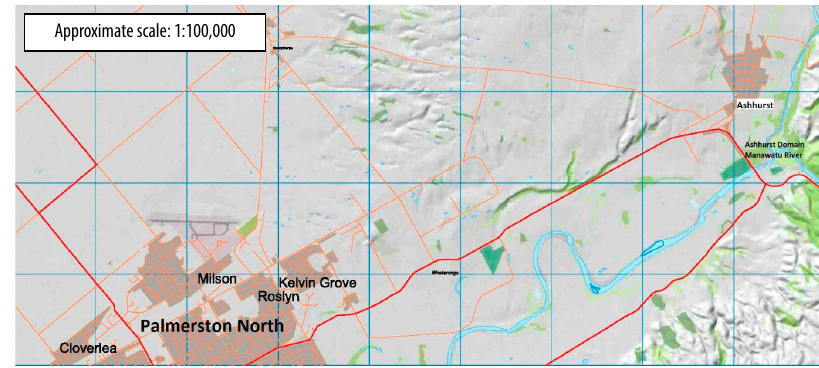
Fig. 1. Map of study